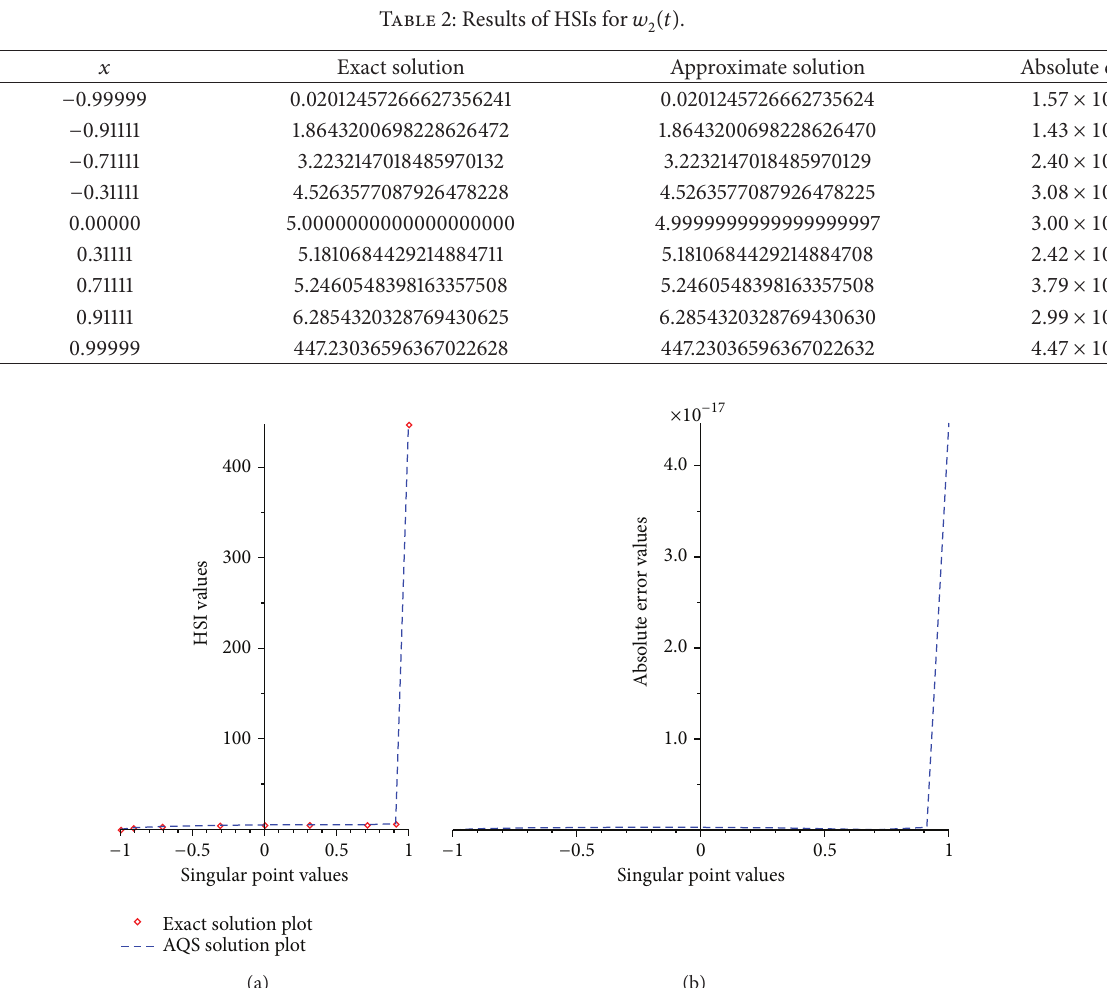
Figure 2: (a) Exact and AQS solutions when 𝑁 = 2 and ℎ(𝑡) = 2𝑡 2 − 3𝑡 + 5 and (b) absolute error between exact and AQS solution when 𝑁 = 2 and ℎ(𝑡) = 2𝑡 2 − 3𝑡 + 5